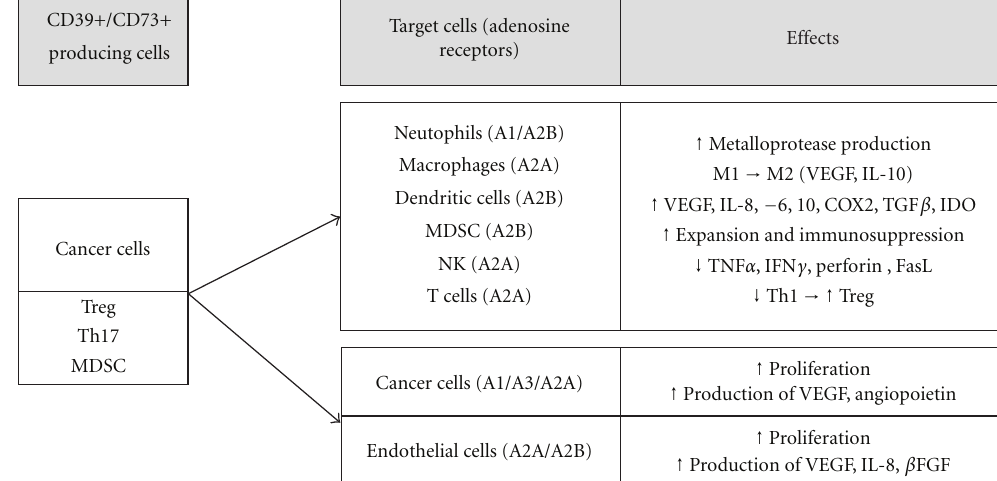
Figure 1: E ff ects of adenosine produced by CD39+/CD73+ cells on target cells. Cancer cells, Tregs, Th17, and MDSCs could produce adenosine through degradation of ATP/ADP by CD39 and CD73. Then adenosine binds on target cells, such as immune cells, cancer cells, or endothelial cells and modifies their